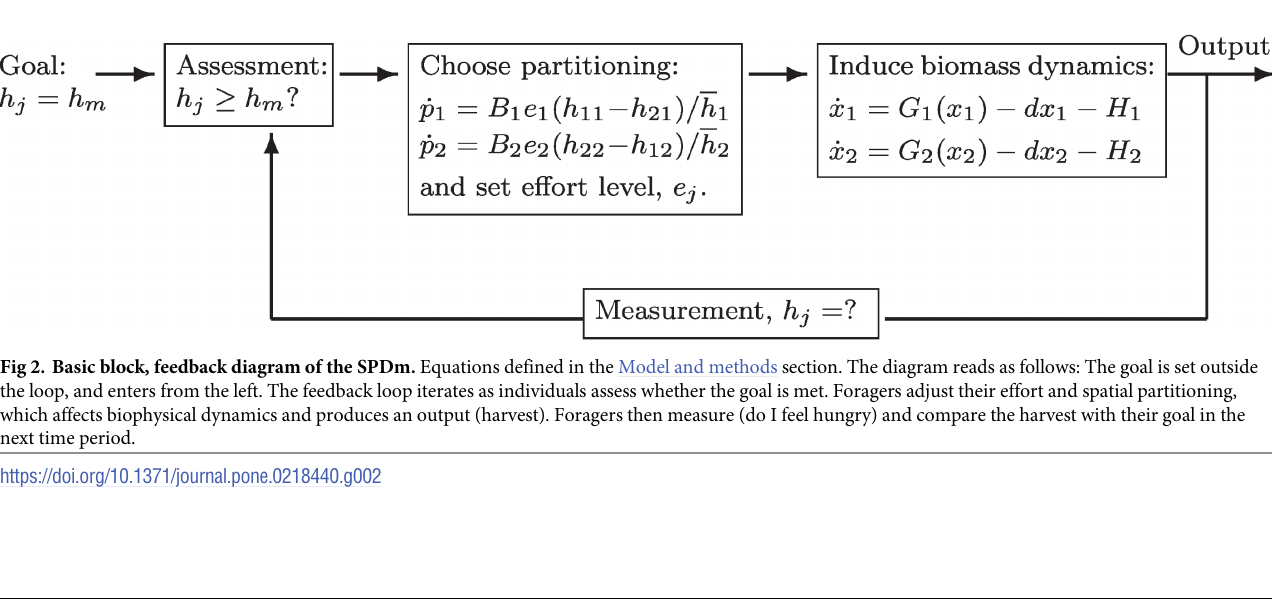
PLOS ONE | https://doi.org/10.1371/journal.pone.0218440 July 11,